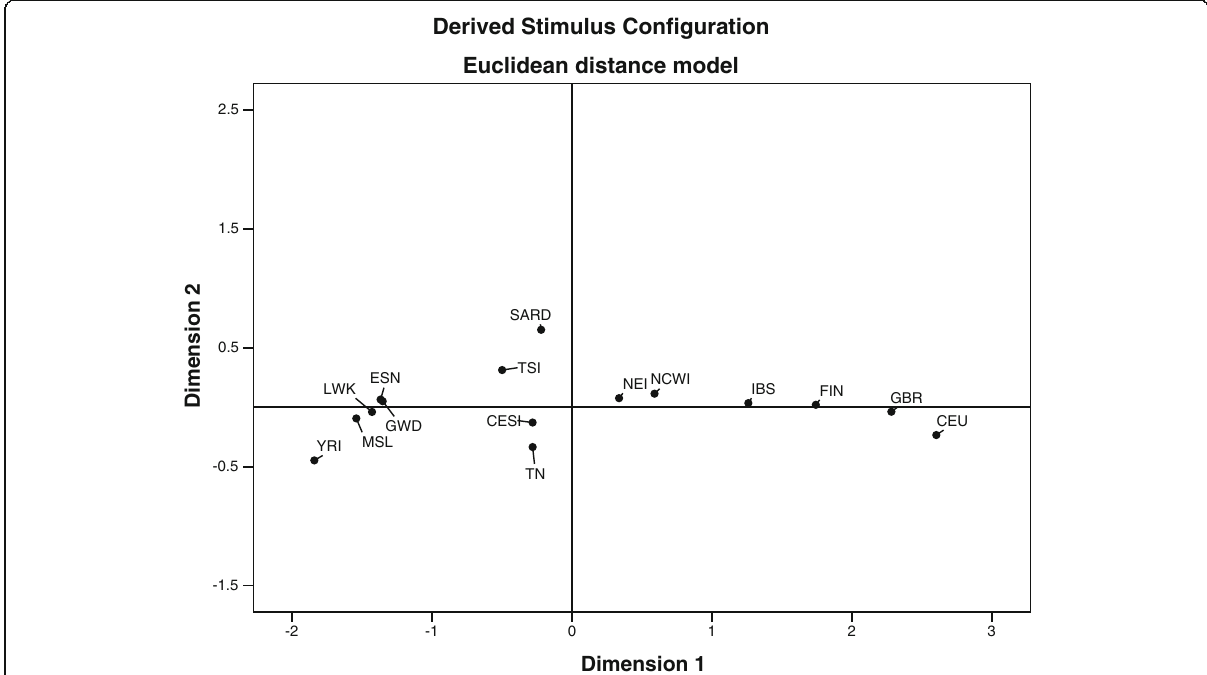
Fig. 1 MDS of Fst estimates based on the LP region for several populations. Non-metric multidimensional scaling analysis of LCT/MCM6 based on Fst distance showing the relationships among the studied populations. ESN Esan in Nigeria, GWD Gambian in Western Division, The Gambia, LWK Luhya in Webuye, Kenya, MSL Mende in Sierra Leone, YRI Yoruba in Ibadan, Nigeria, TSI Tuscany in Italy, CESI Central-Eastern Southern Italy, NEI North-Eastern Italy, NCWI North Central Western Italy, SARD Sardinia, IBS Iberian populations in Spain, FIN Finnish in Finland, GBR British in England and Scotland, CEU Utah residents (CEPH) with Northern and Western European ancestry, TN Tunisian